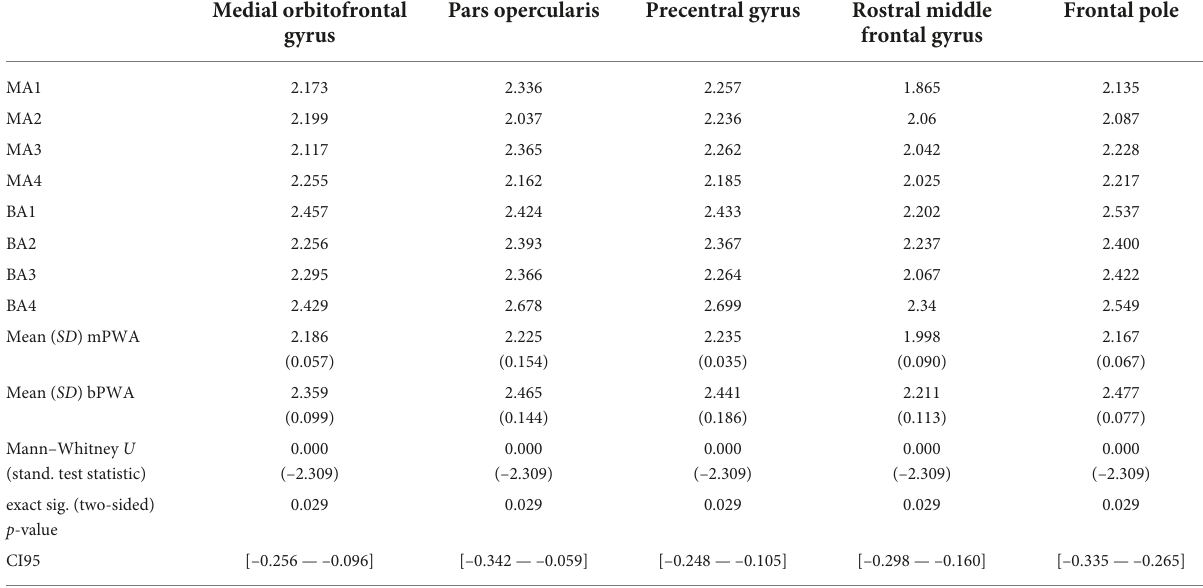
Theresultspresenteddonotsurvivecorrectionformultiplecomparisons. TABLE 8 Right hemisphere cortical thickness with significant group difference between monolingual and bilingual participants with